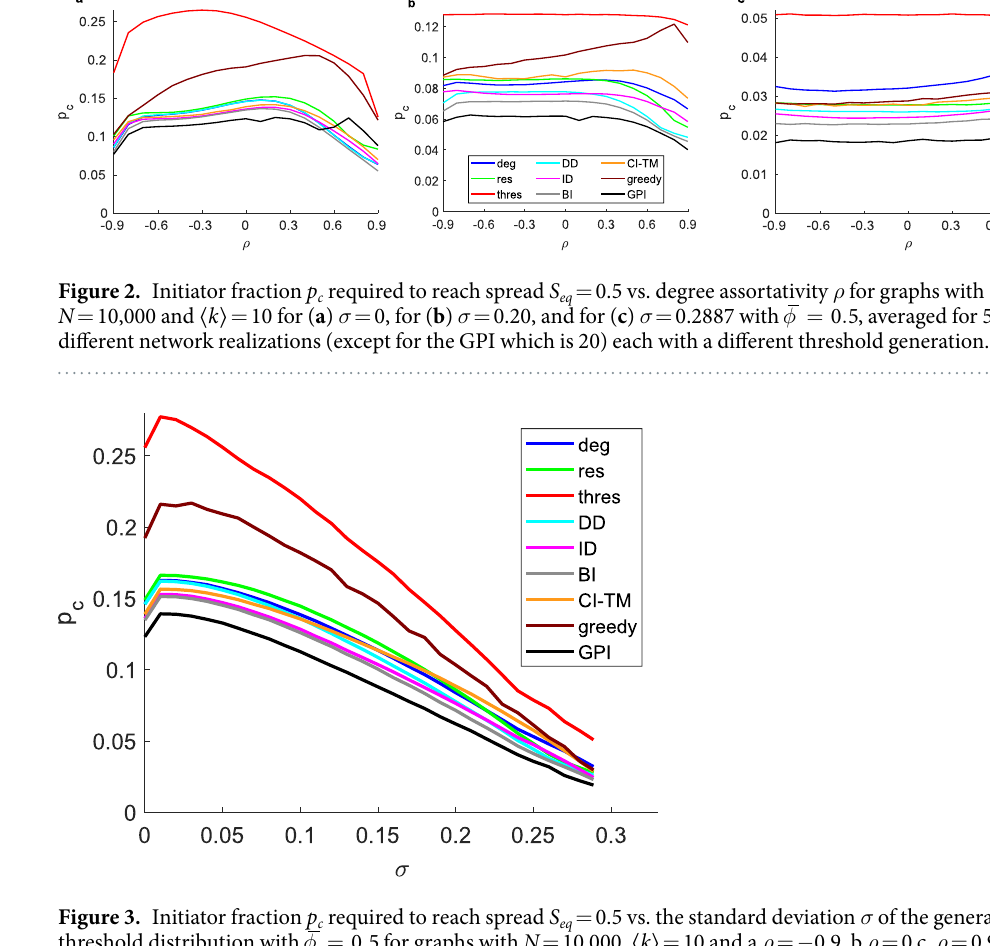
Figure 3. Initiator fraction p c required to reach spread S eq = 0.5 vs. the standard deviation σ of the generated threshold distribution with φ = . 0 5 for graphs with N = 10,000, 〈 k 〉 = 10 and a ρ = − 0.9, b ρ = 0 c, ρ = 0.9, averaged for 500 different network realizations (except for the GPI which based on 20 realizations) each with a different threshold generation.